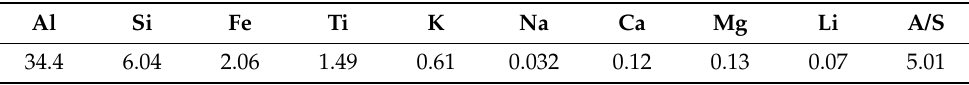
Table 2. Chemical composition of lithium-bearing bauxite (%).